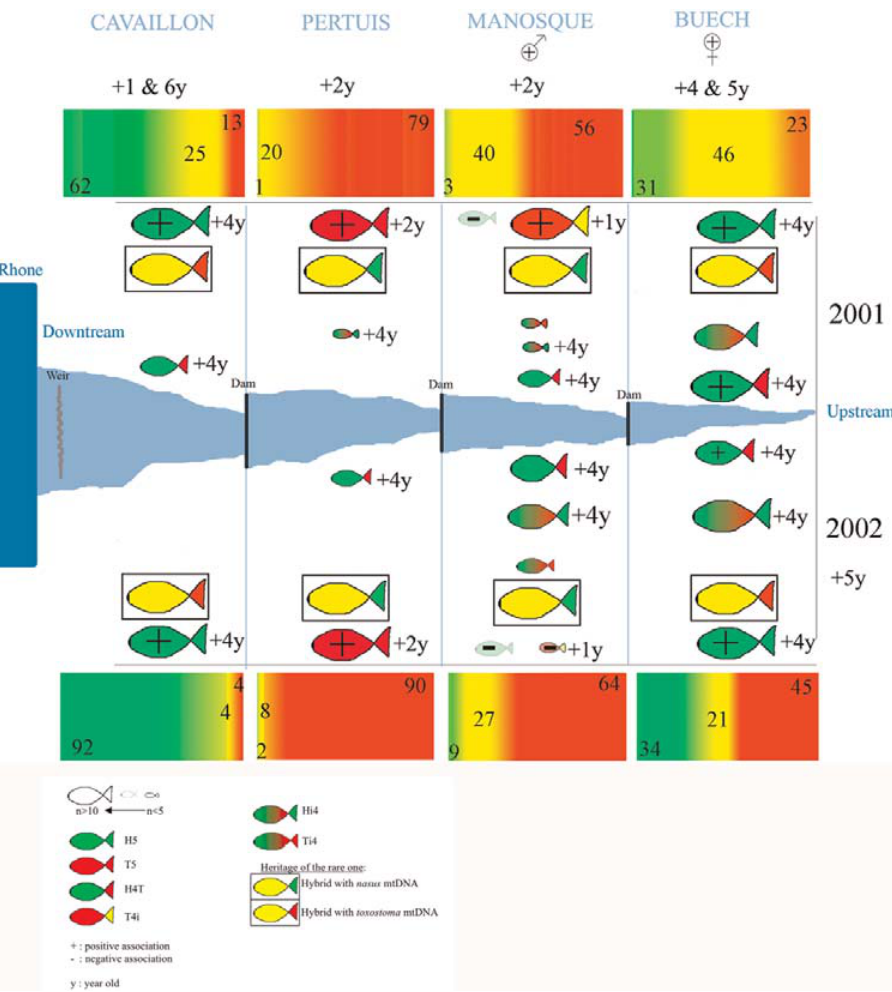
Figure 6. GENOMIC EVOLUTION THROUGH THE HYBRID ZONE. Global summary of the dynamics of the hybrid zone and main variable interactions (chi-square test and log-linear model) with respect to the various sampling years and stations (see the text for more detail). The percentages of the different categories are shown—from T5 in red to H5 in green, and ‘‘hybrids’’ in yellow—separately for each station and each sampling year.